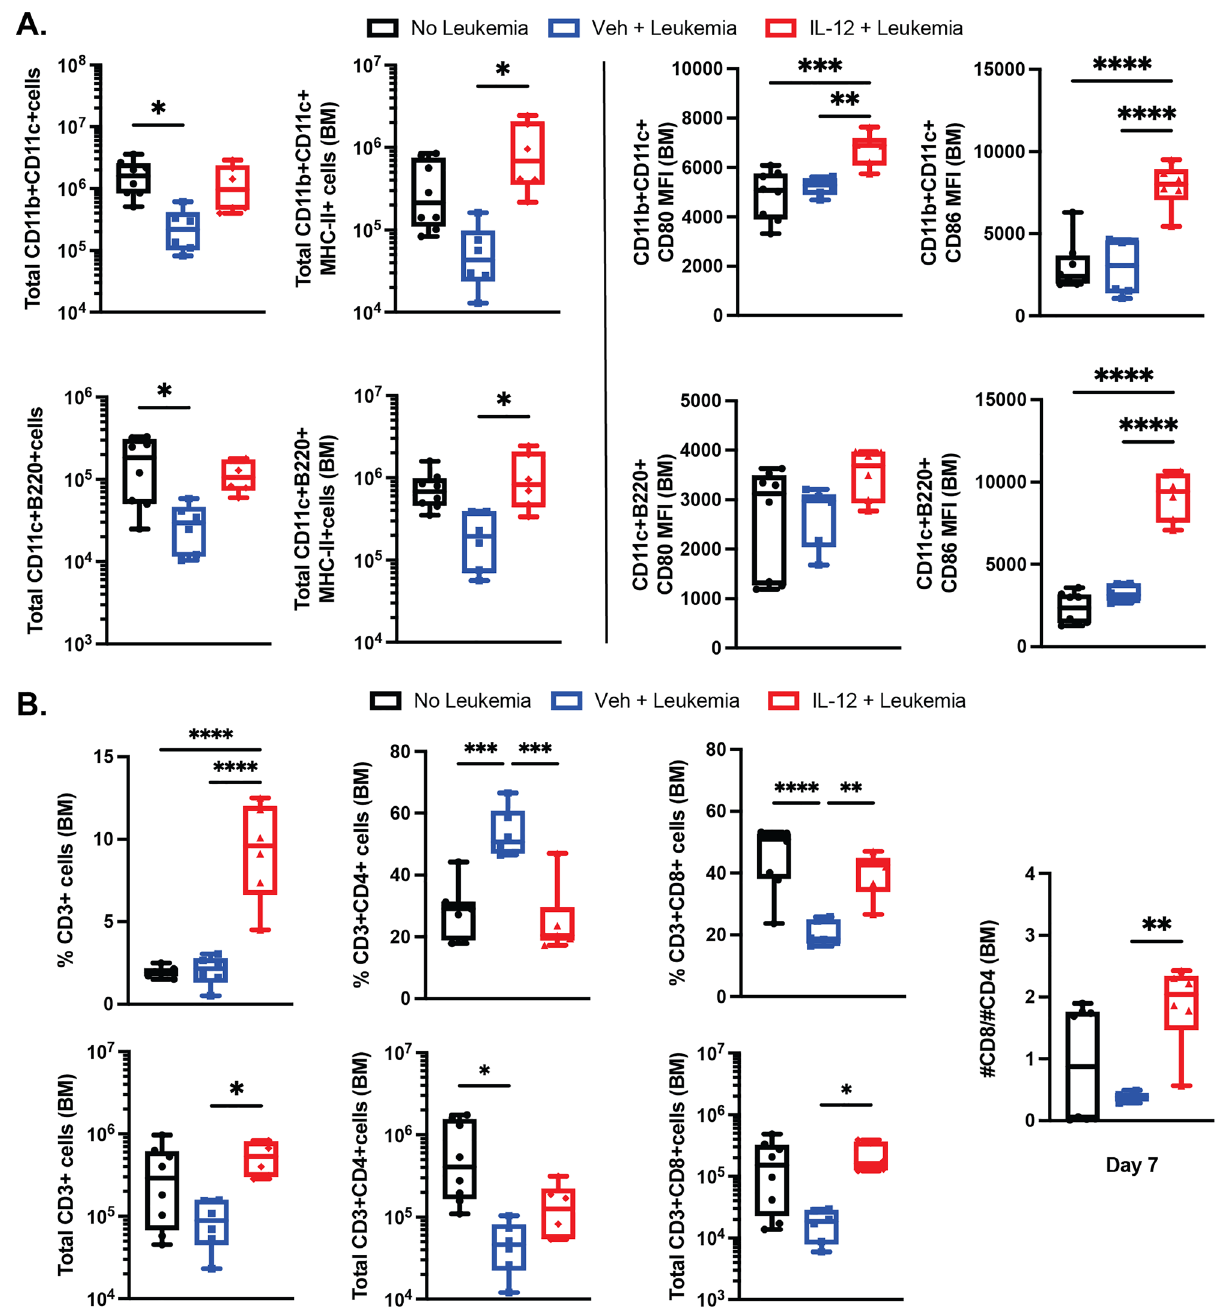
Figure 3. B-ALL induces cellular changes in the B-ALL microenvironment that can be normalized by IL-12. Parental BCR-ABL1 + /Arf −/− leukemia cells were injected into unirradiated WT recipients. On day 3, treatment with either rIL12 or BSA was begun (1 μg/dose, intraperitoneal, on days 3–7, 10–12); n = 6/group from two independent experiments). ( A ) Total CD11b + CD11c + cells and CD11c + B220 + cells, as well as total MHCII + cells and CD86 and CD80 mean fluorescence intensity (MFI) of each cell population, respectively. ( B ) The percentage (top) and total number (bottom) of specified T-cell populations in the bone marrow. The ratio of the number of CD8 to CD4 cells is also shown (right). (ANOVA with Tukey multiple comparison